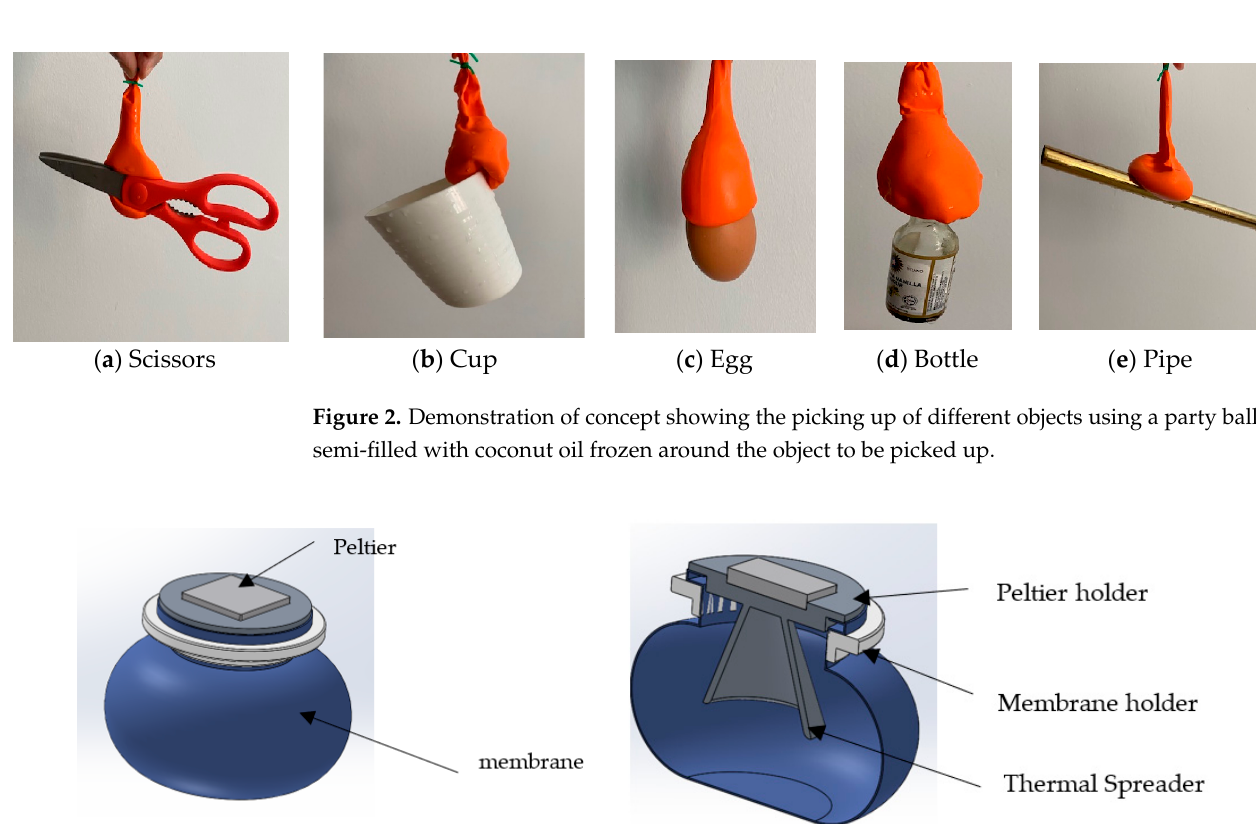
Figure 3 . ( a ) Concept design of liquid jamming gripper and ( b ) cross section with details.